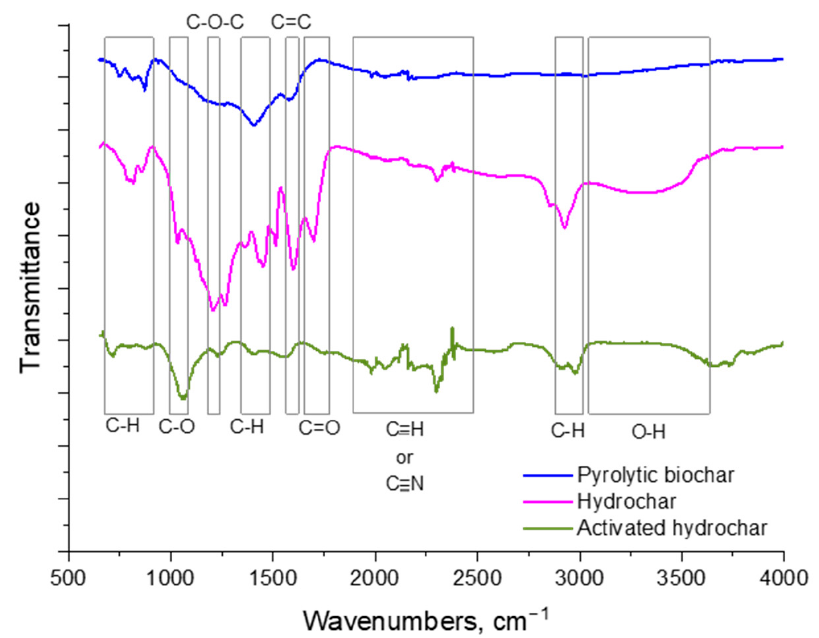
Figure 1. FTIR spectra of studied biosorbents